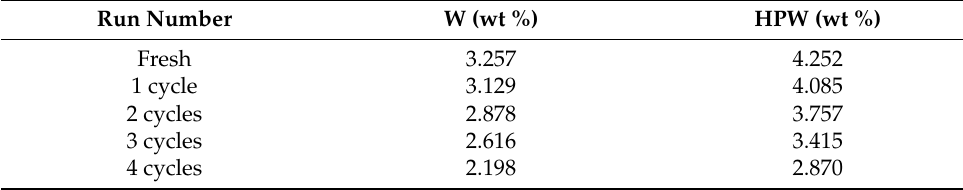
Figure 8. Effect of recycling times on DBT conversion. Table 2. HPW content in the 5%HPW/SF-HPC catalyst.